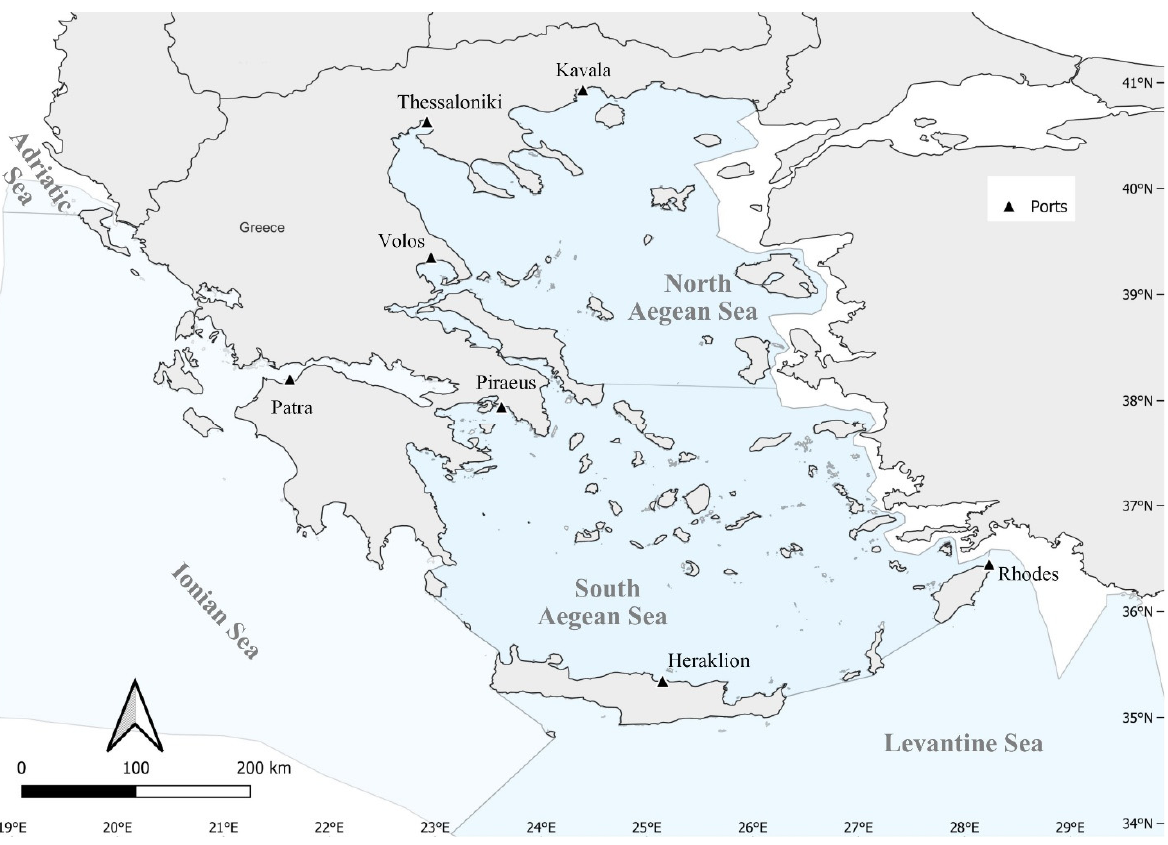
Figure 1. Map of the study area featuring the four marine ecoregions forming the Greek Seas (the Aegean Sea, the Levantine Sea, the Ionian Sea, and a small part of the Adriatic Sea) along with seven major commercial ports (black triangles). Ecoregions are delimited according to the Marine Reporting Units (MRUs) of the Marine Strategy Framework Directive (MSFD) [8].